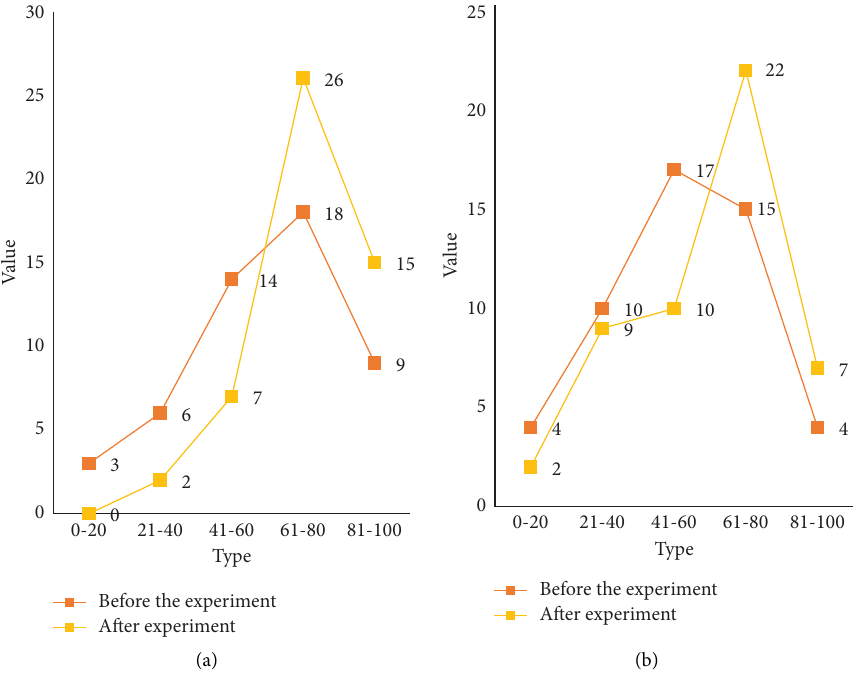
Figure 5: Statistical chart of students’ literacy achievements. (a) Grade of experimental class. (b) Grade of the control